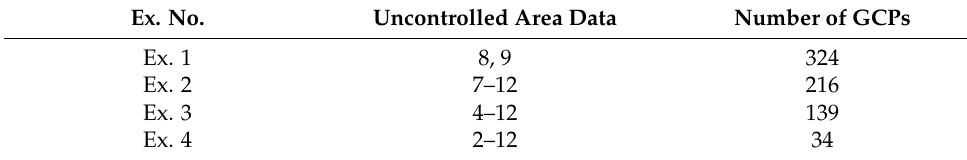
Table 1. The data contained in the uncontrolled